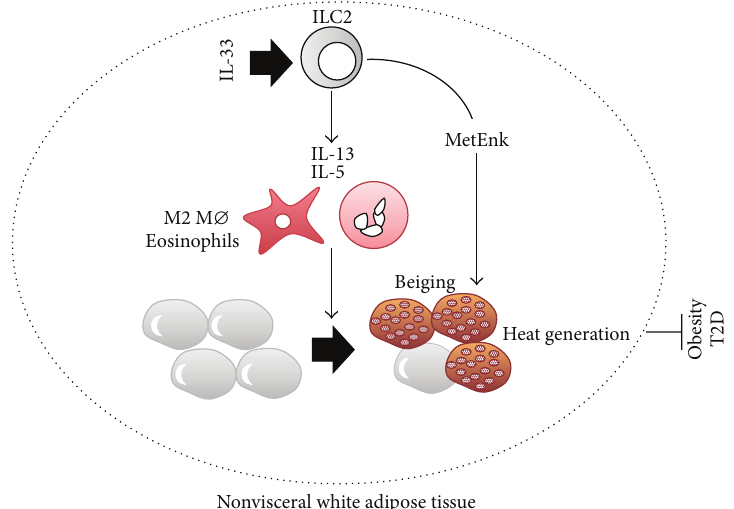
Figure 6: IL-33–ILC2 beiges white adipose tissue to protect against obesity via heat generation and energy expenditure. IL-33–ILC2–IL-13/IL- 5 is also critical for transformation of white adipocytes into thermogenic beige adipocytes. In response to IL-33, ILC2 in white adipose tissue produces methionine-enkephalin peptide (MetEnk) as well as pro-allergic IL-13 and IL-5. IL-13 and IL-5 induce recruitment and activation of eosinophils and cell conversion of Mø into M2 Mø. MetEnk, combined with M2 Mø and eosinophils, contributes to beiging of white adipocytes, which leads to protection against obesity and the related disease T2D via heat generation and energy consumption. ILC2: group 2 innate lymphoid cells; MetEnk: methionine-enkephalin peptide; Mø: macrophages; T2D: type 2 diabetes